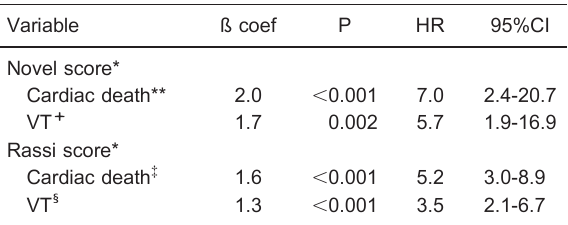
Table 4. Cox proportional hazard model analyses of novel and Rassi scores for cardiac death and VT endpoints, assessed separately.